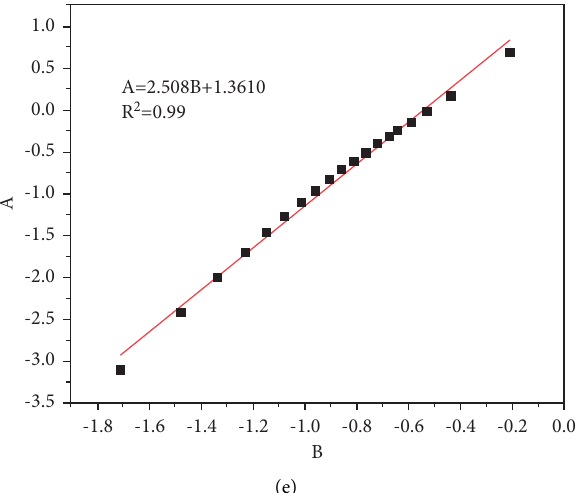
Figure 3: The impact of D